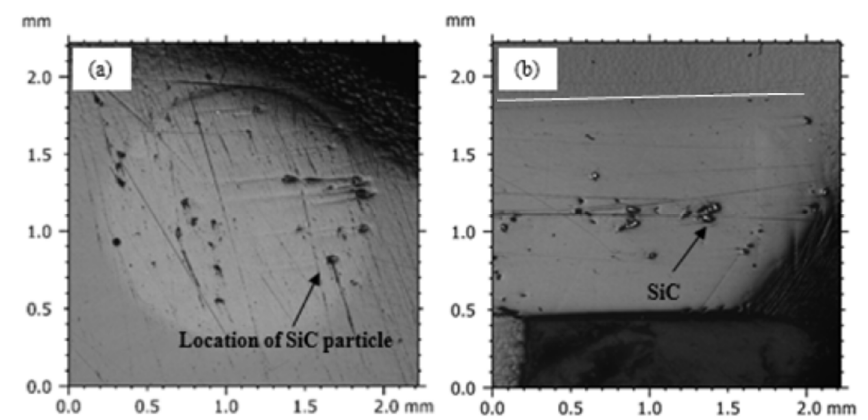
Figure 8. ( a ) Cross-sectional and ( b ) longitudinal view of 2 wt% PLA-SiC filament. Horizontal lines are added to highlight the filament boundaries.